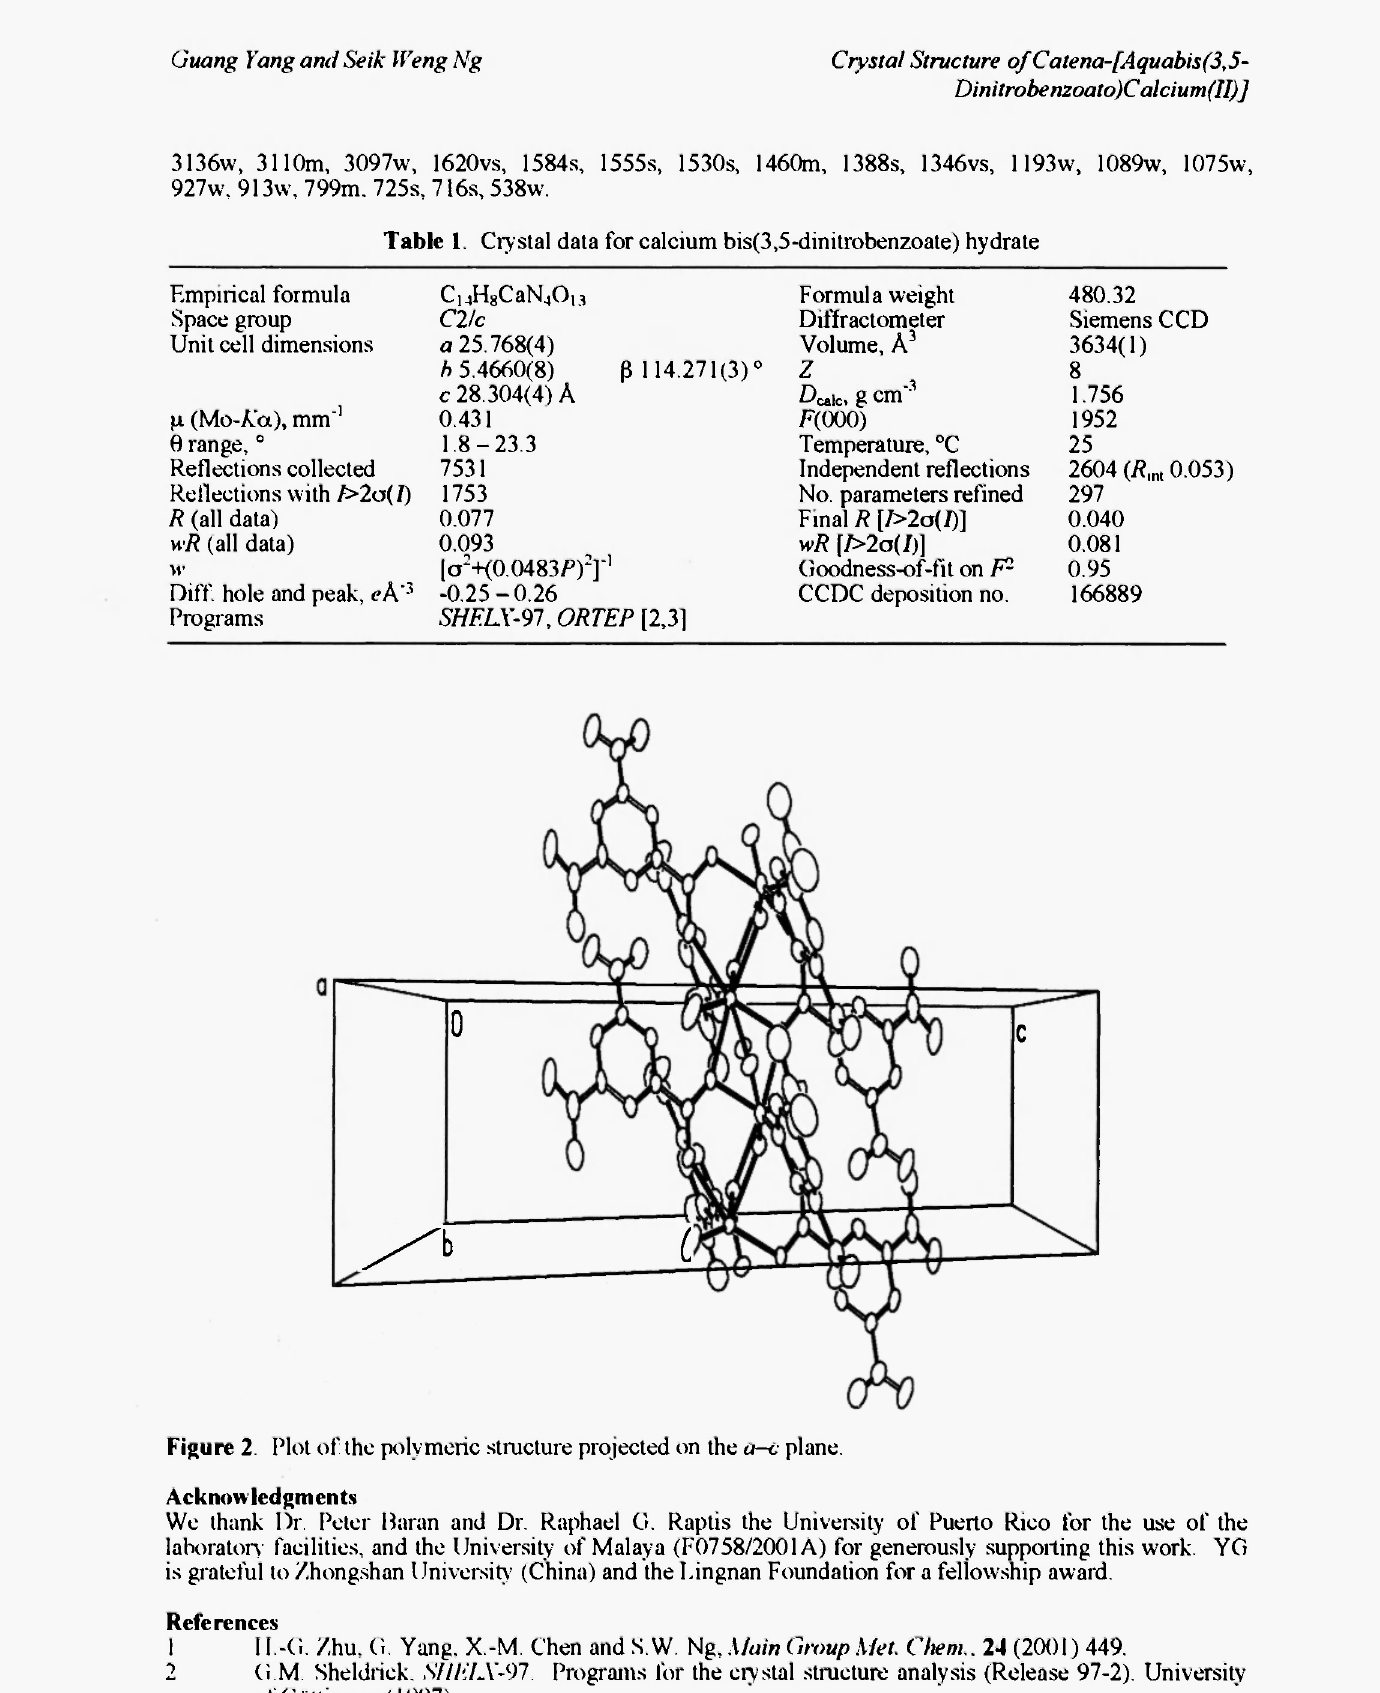
Table 1. Crystal data for calcium bis(3,5-dinitrobenzoate) hydrate